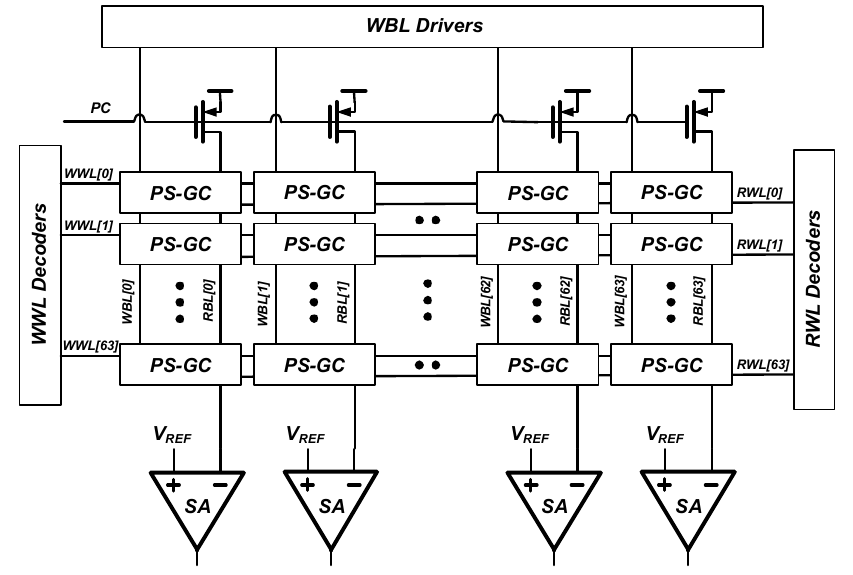
Figure 11. Overall architecture of the 4 kb eDRAM macro.